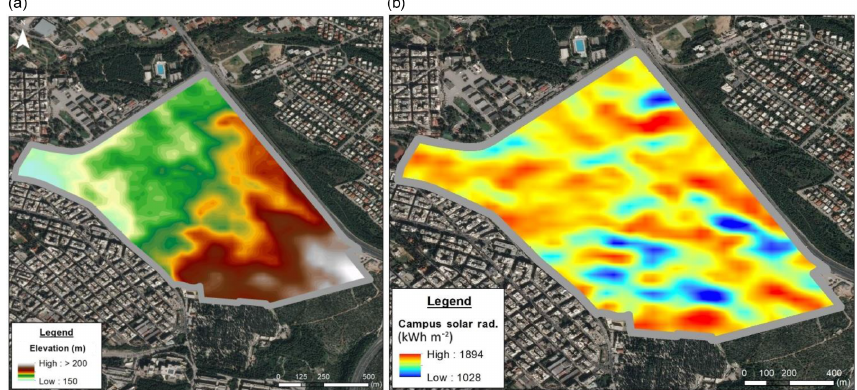
Figure 2. (a) Digital elevation model (DEM) of the campus. (b) The total solar radiation at the campus area. (Base Map Layer: Bing Map v.7, Bing Satellite Base